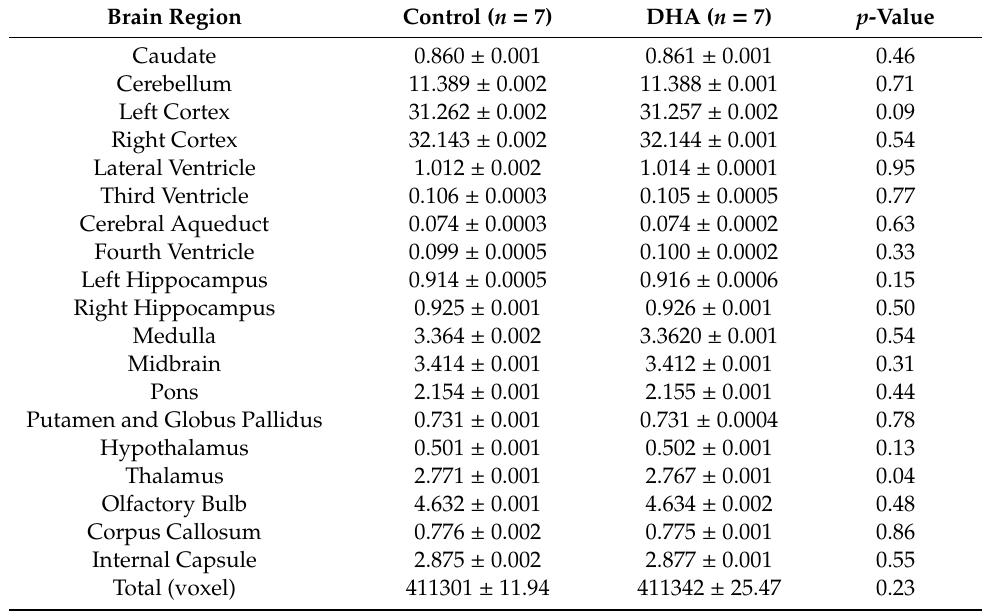
Table 4. Structural magnetic resonance imaging (MRI) analysis of nineteen brain regions of piglets at